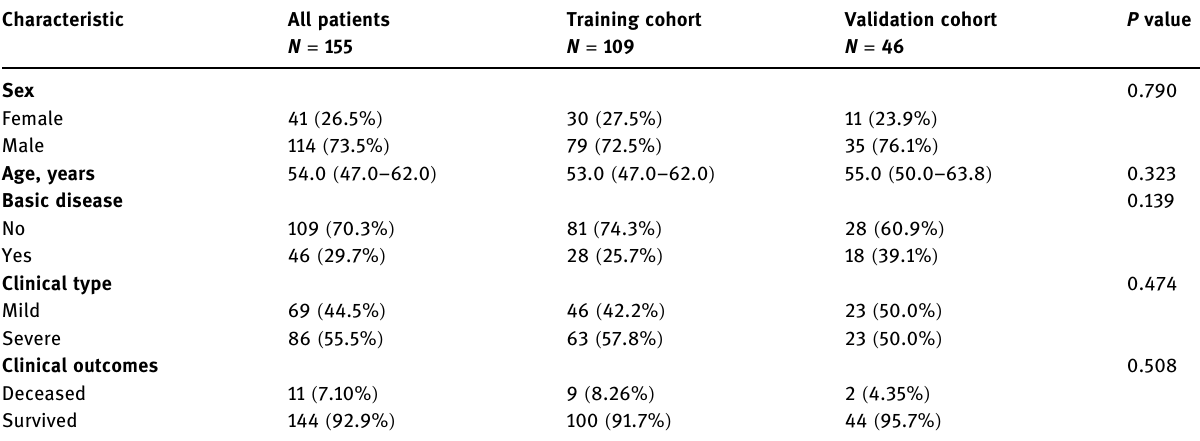
Table 1: Baseline characteristics of patients with HFRS in the training and validation cohorts